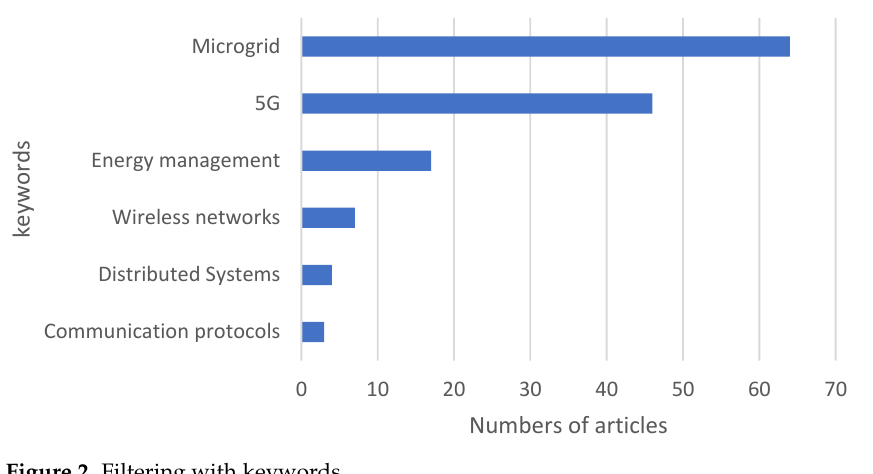
Figure 2. Filtering with keywords.